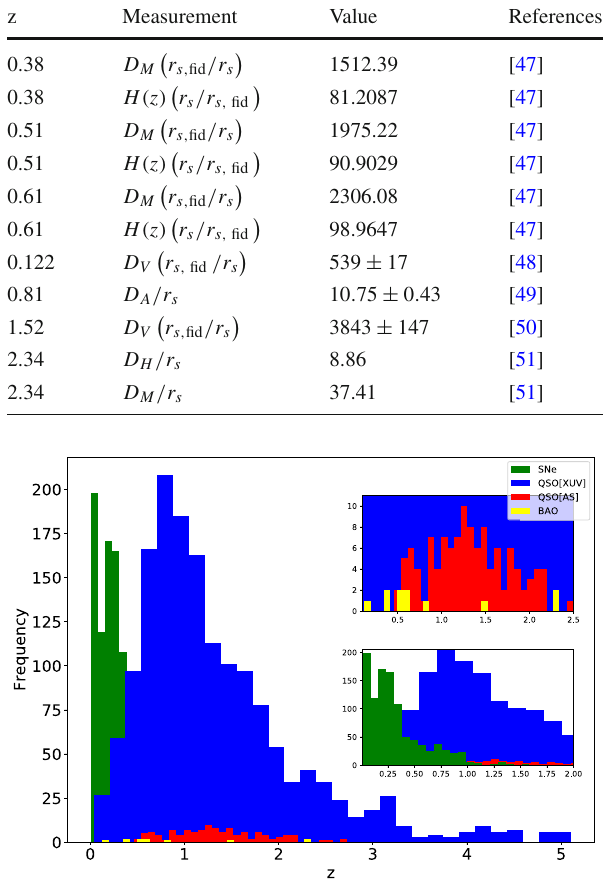
Fig. 1 The redshift distribution of the SNe Ia, quasars, and BAO mea- surements terms of fluxes, F = L / 4 π D L ( z ) 2 , Eq. (15)